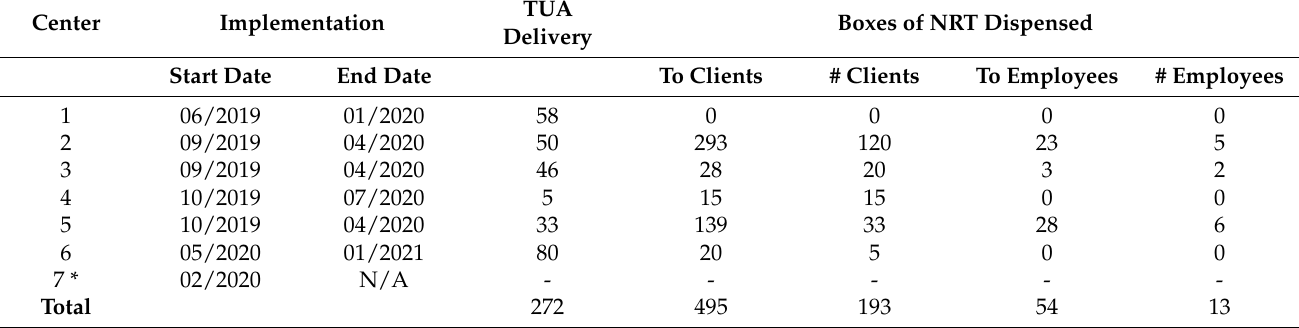
Table 4. Tobacco Use Assessments (TUAs) Delivered to Clients and Nicotine Replacement Therapy (NRT) Boxes Dispensed to Clients and Employees of Participating Opioid Treatment Centers Post- Program